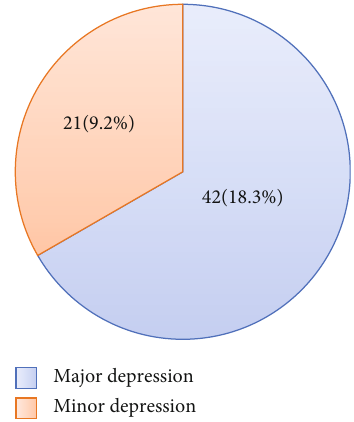
Figure 1: Distribution of major and minor depression on study respondents at the neurology clinic of Zewditu Memorial Hospital in Addis Ababa, Ethiopia ( n = 63